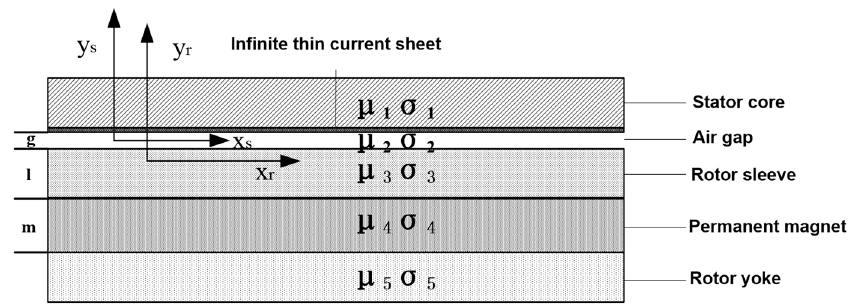
Figure 4. The two-dimensional model of the motor in rectangular coordinates.